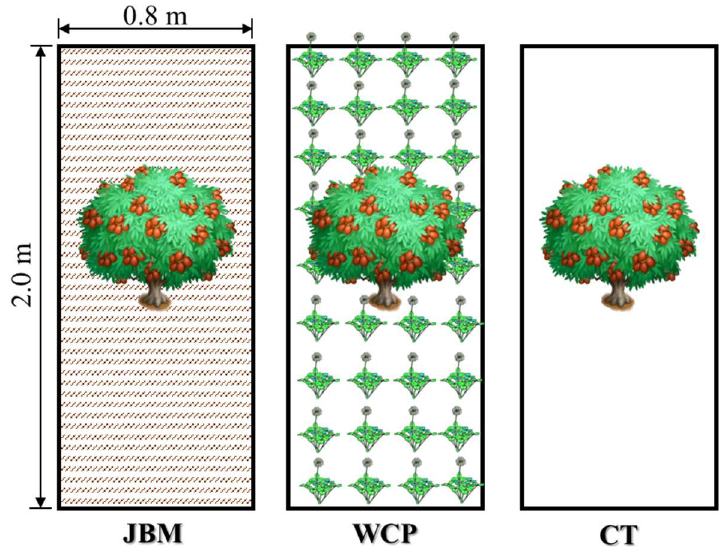
Figure 5. Layout diagram for experimental treatments (JBM, WCP, and CT).